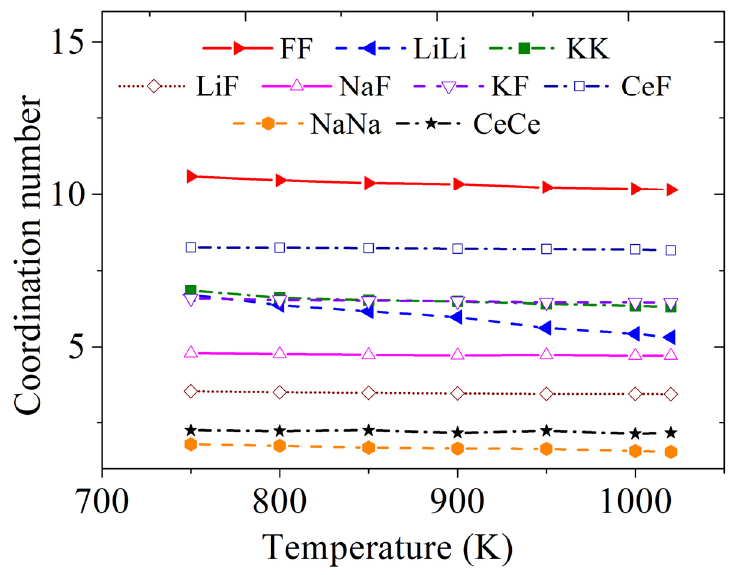
Figure 8. Temperature dependence of the first coordination numbers of ions in the molten salt mixture FLiNaK+15 mol.% CeF 3 .